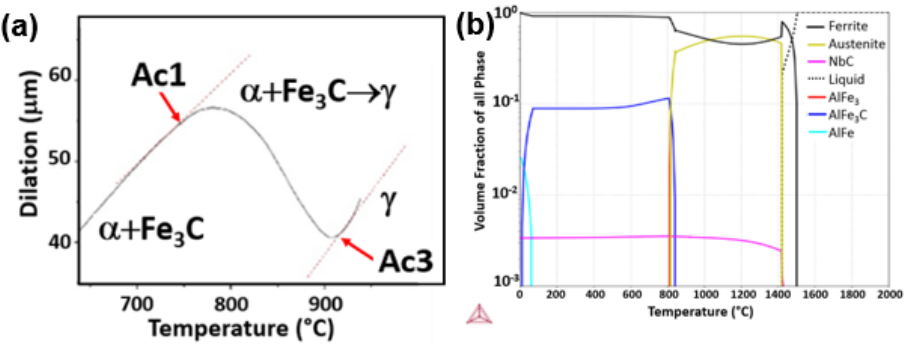
Figure 10. ( a ) Dilatometric profile on heating of classical steels, showing a single-phase field at high temperatures [21]; ( b ) diagram of the volume fractions at equilibrium calculated for the Fe-Mn-Al-C alloy using the Thermo-Calc software